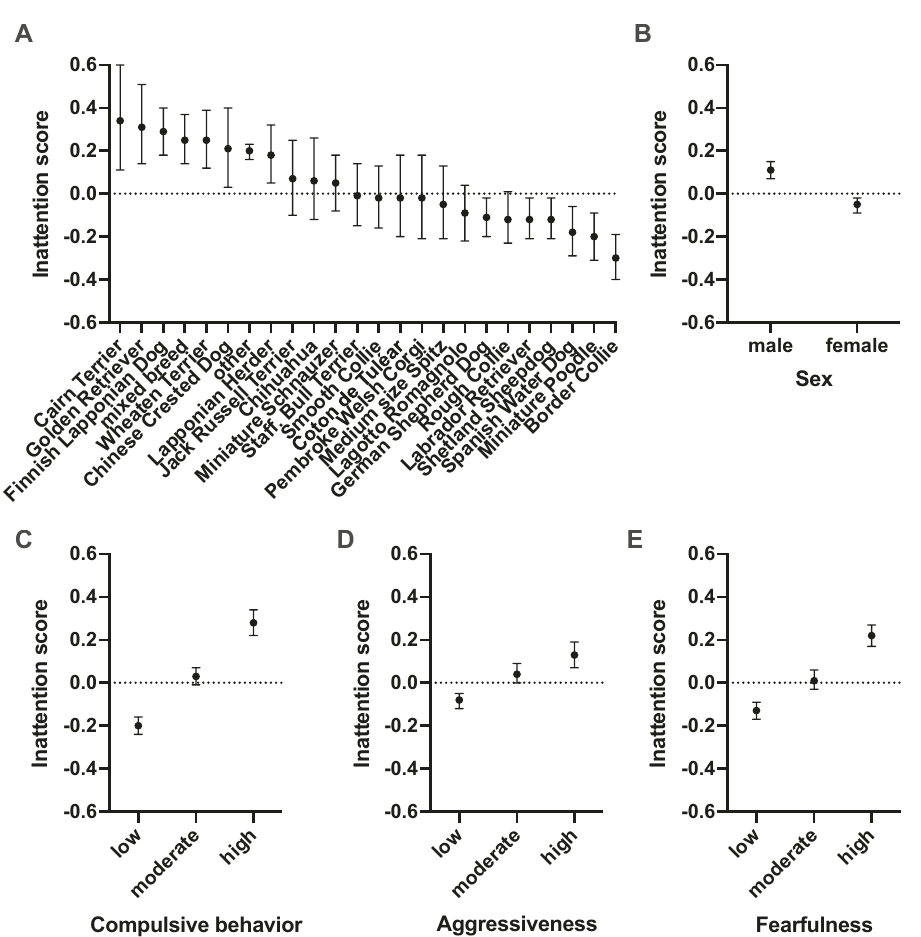
Fig. 2 Canine inattention. The effects of breed ( A ), sex ( B ), compulsive behaviour ( C ), aggressiveness ( D ) and fearfulness ( E ) on canine inattention. Error bars indicate 95% con fi dence limits. N =